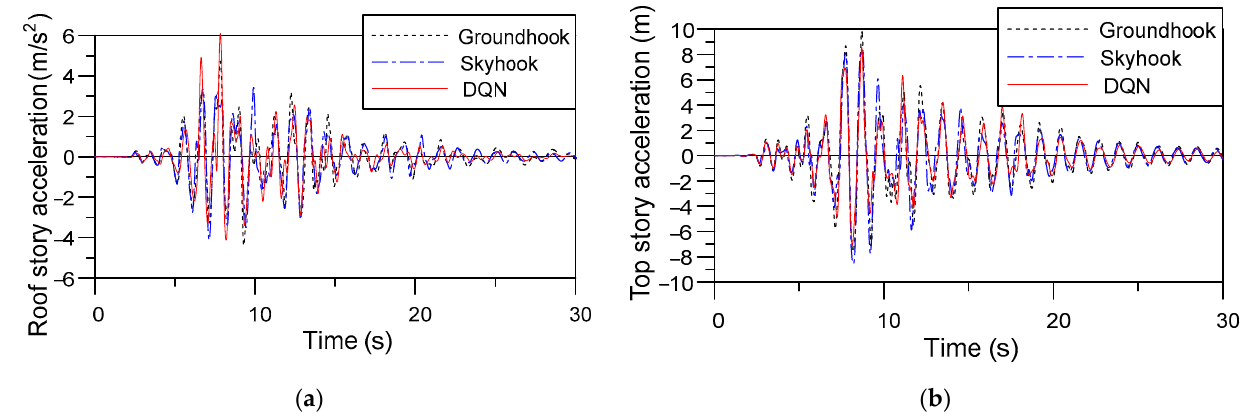
Figure 16. Comparison of the roof story acceleration time histories: ( a ) responses to EV1, ( b ) responses to EV2.